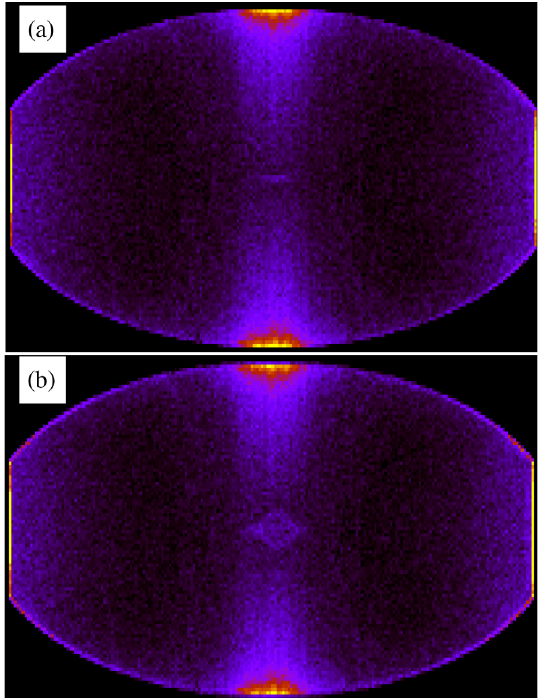
FIG. 27. Simulated electron cloud density during the (a) third and (b) sixth of 11 time slices during of the passage of bunch 15, which has been offset from the centered bunch train by 1 mm horizontally to simulate the effect of kicking a single bunch when measuring its tune. The “ pinched ” cloud is found to be centered on the offset bunch position. The short bunch length (16 mm) bunch results in little effect on the larger built-up cloud. The simulated bunch current is 2 mA = bunch. At higher currents, the vertical band widens ( 4 mA = bunch) and splits into two ( 6 mA = bunch). (Beam energy is 5.3